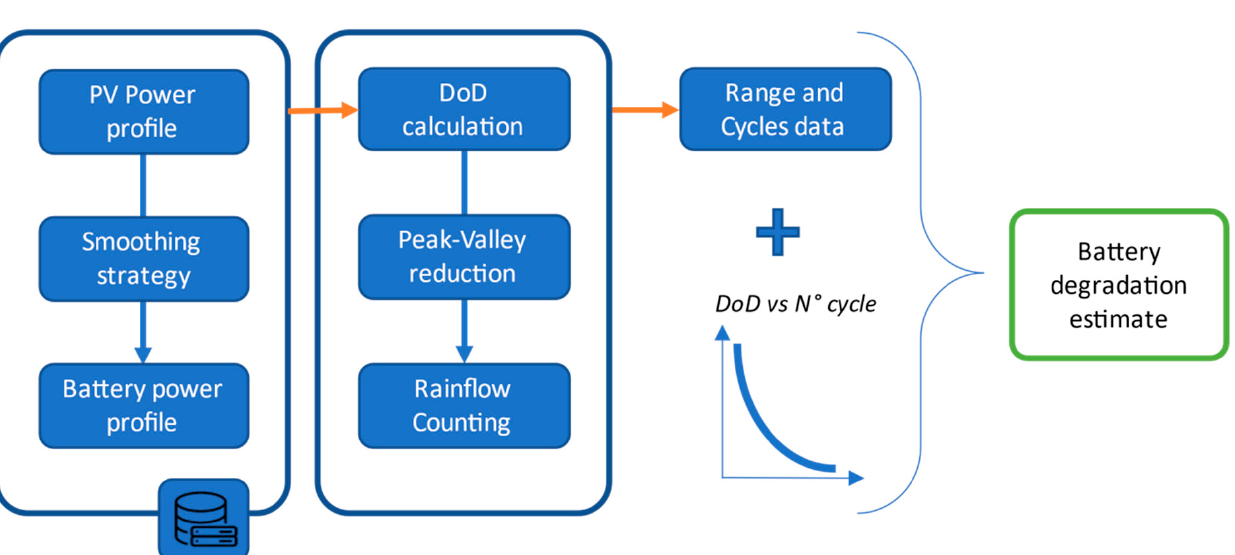
Figure 3. Number of cycles versus DoD for different lithium technologies.